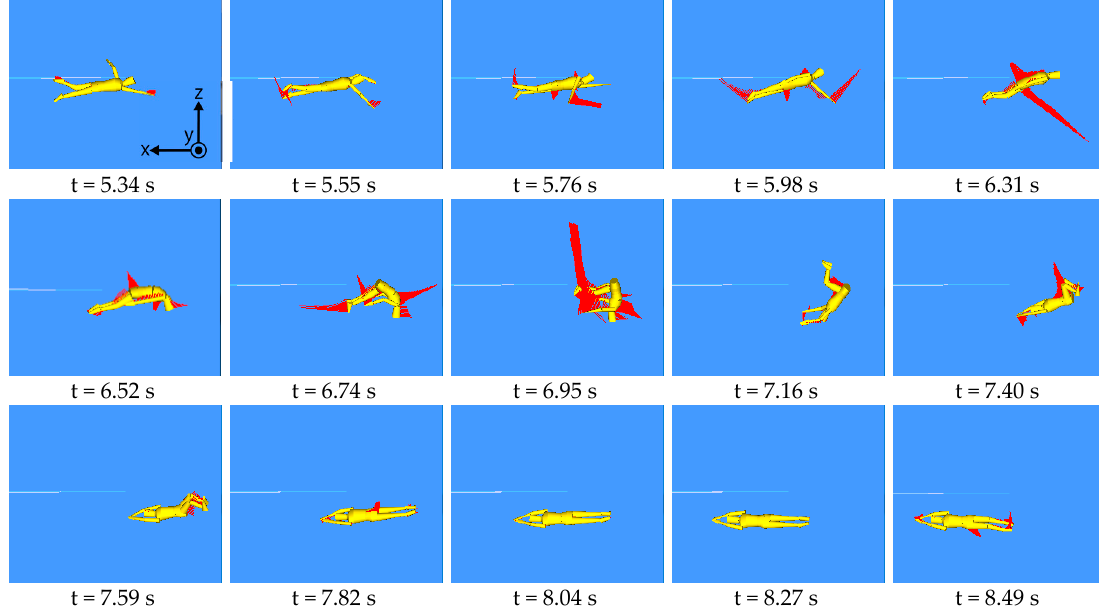
Figure 3. The simulated swimming motion the flip turn.